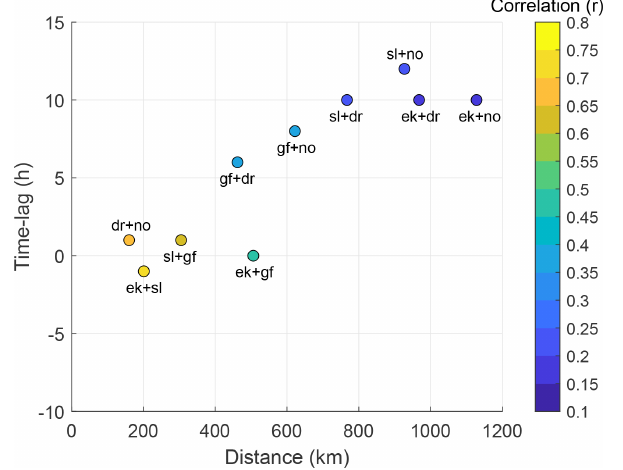
Figure 5. Time lag (h) of maximum correlation between the con- nected sites as a function of the distance between